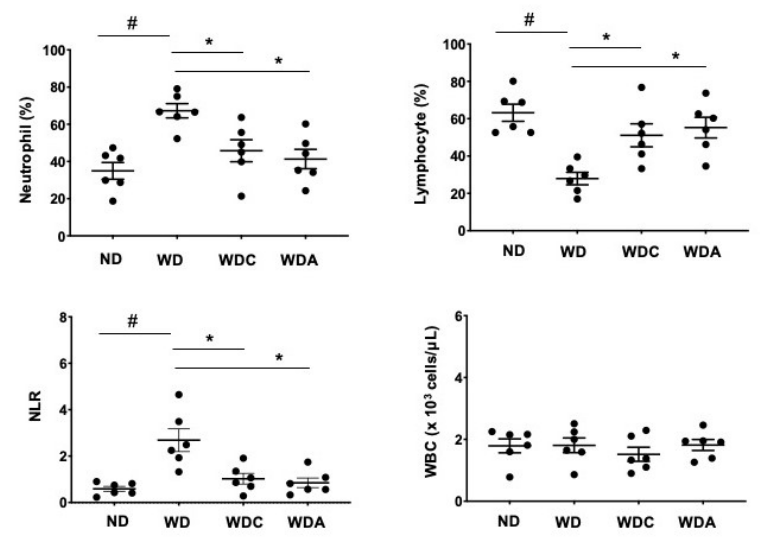
Figure 4. Capsanthin attenuated the neutrophil-to-lymphocyte ratio (NLR) of Western-type diet (WD)-fed ApoE − / − mice. White blood cells (WBC), neutrophils, and lymphocytes were analyzed from complete blood cells using a hematology analyzer. NLR was calculated by dividing neutrophils by lymphocytes in each experimental group. All values represent the mean ± SEM ( n =6). # p < 0.05 vs. the ND group; * p < 0.05 vs. the WD group. ND: normal diet, WD: Western-type diet, WDC: capsanthin with Western-type diet, WDA: atorvastatin with Western-type diet.